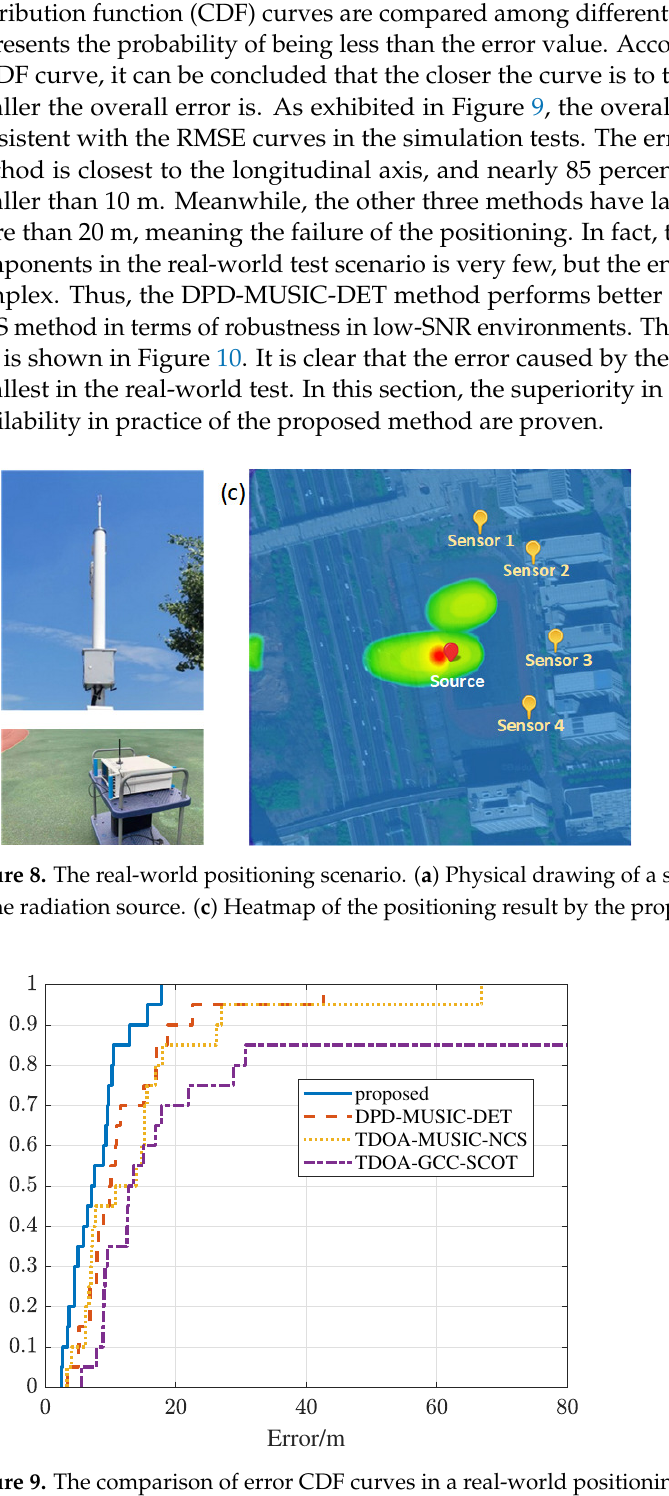
Figure 9. The comparison of error CDF curves in a real-world positioning